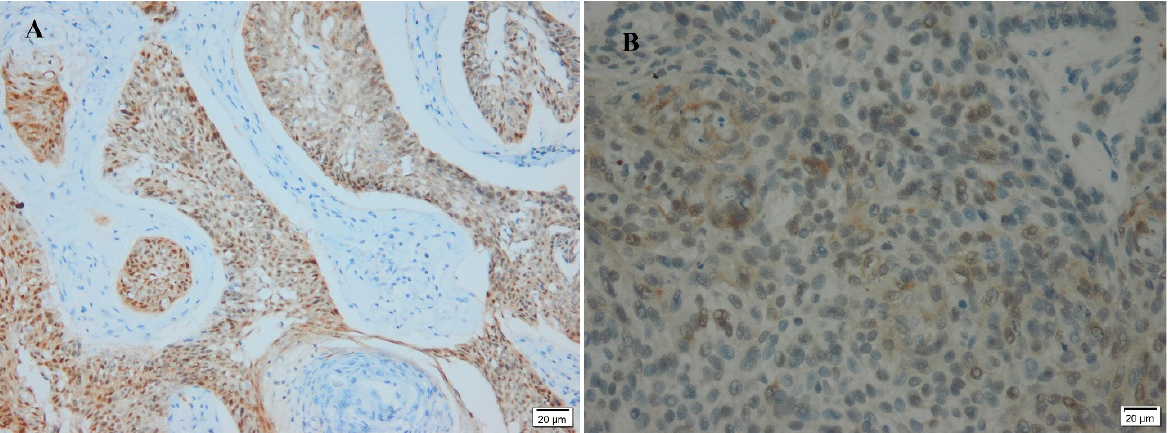
Figure 3. Immunohistochemical staining of p16 marker in a case of BCC showing: ( A ) strong positivity (200×); ( B ) moderate positivity in (400×).